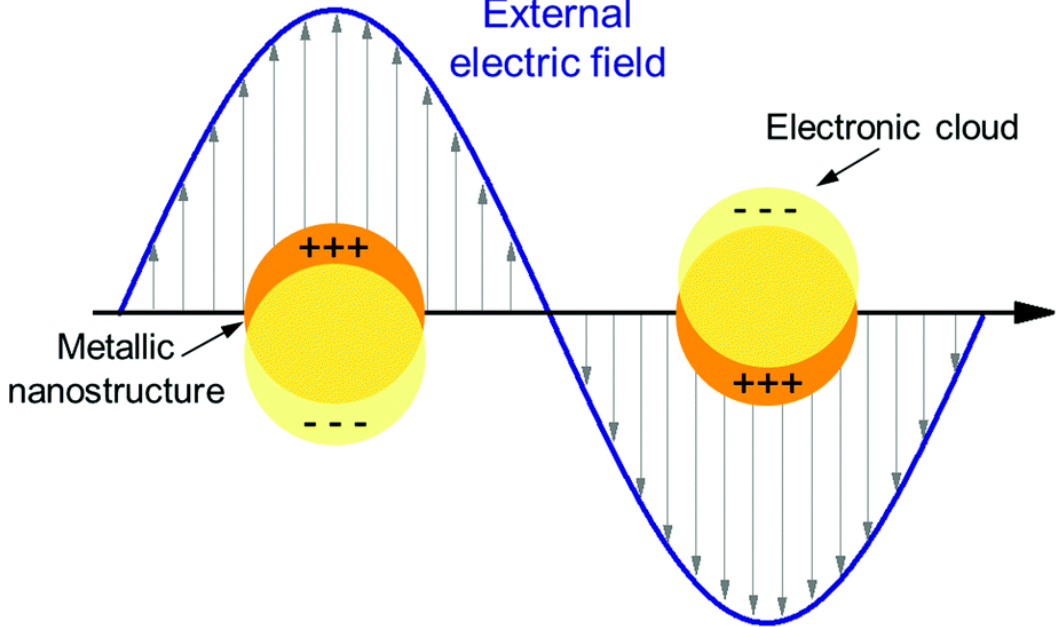
Figure 1. Plasmonic behavior of a metal surface, showing localized surface plasmon formation in the presence of an electromagnetic wave. Reproduced from [25]. Published by The Royal Society of Chemistry, 2017.